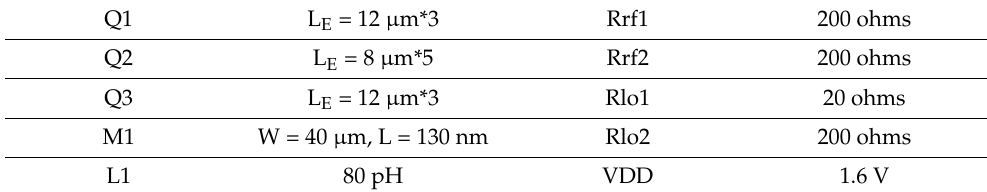
Table 1. Values of some main components.